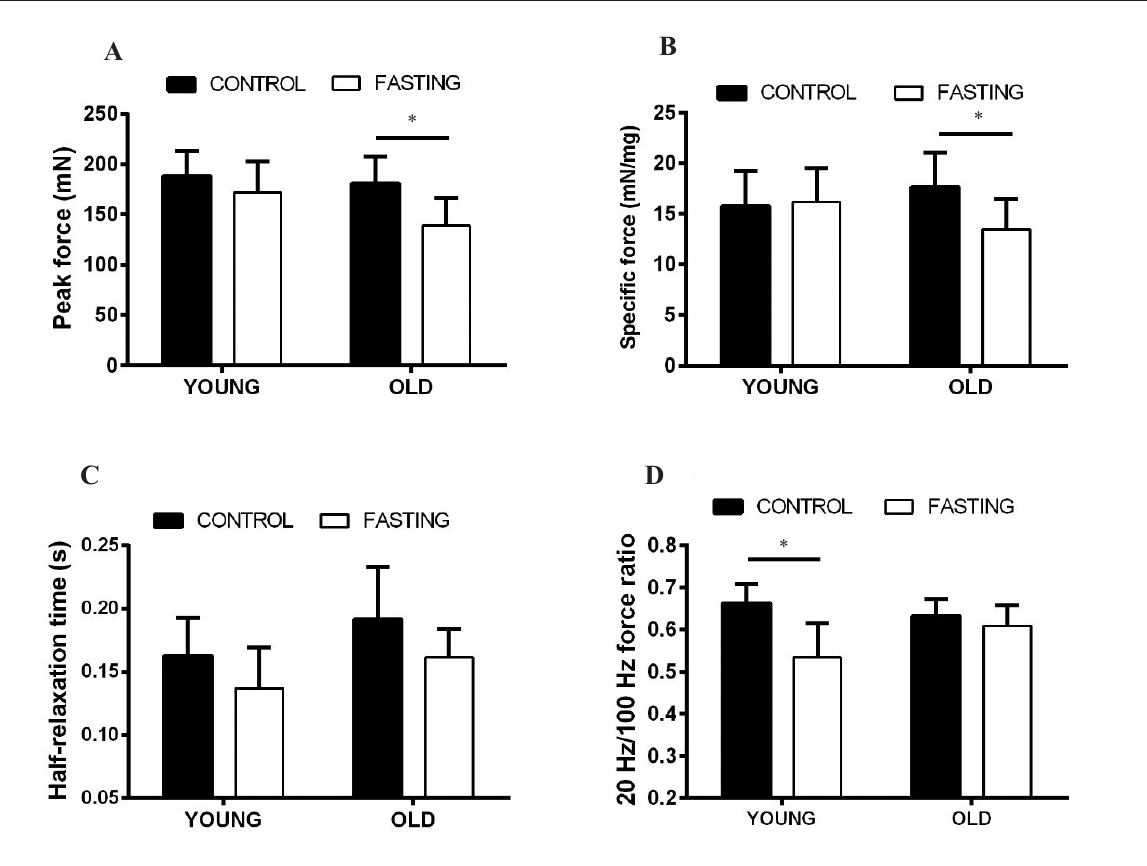
2. Peak force (A), specific force (B), half-relaxation time (C) and 20 Hz to 100 Hz force ratio (D) for soleus (SOL) muscle from the control and fasting groups of young and old mice,